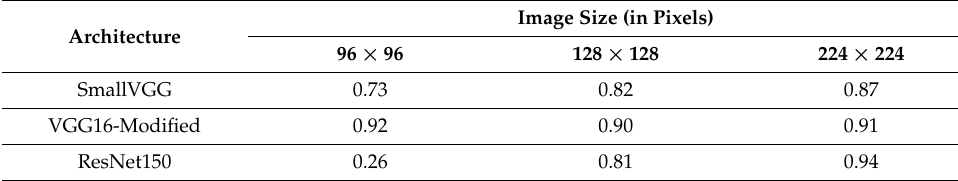
Table 4. CNN accuracy results for different image